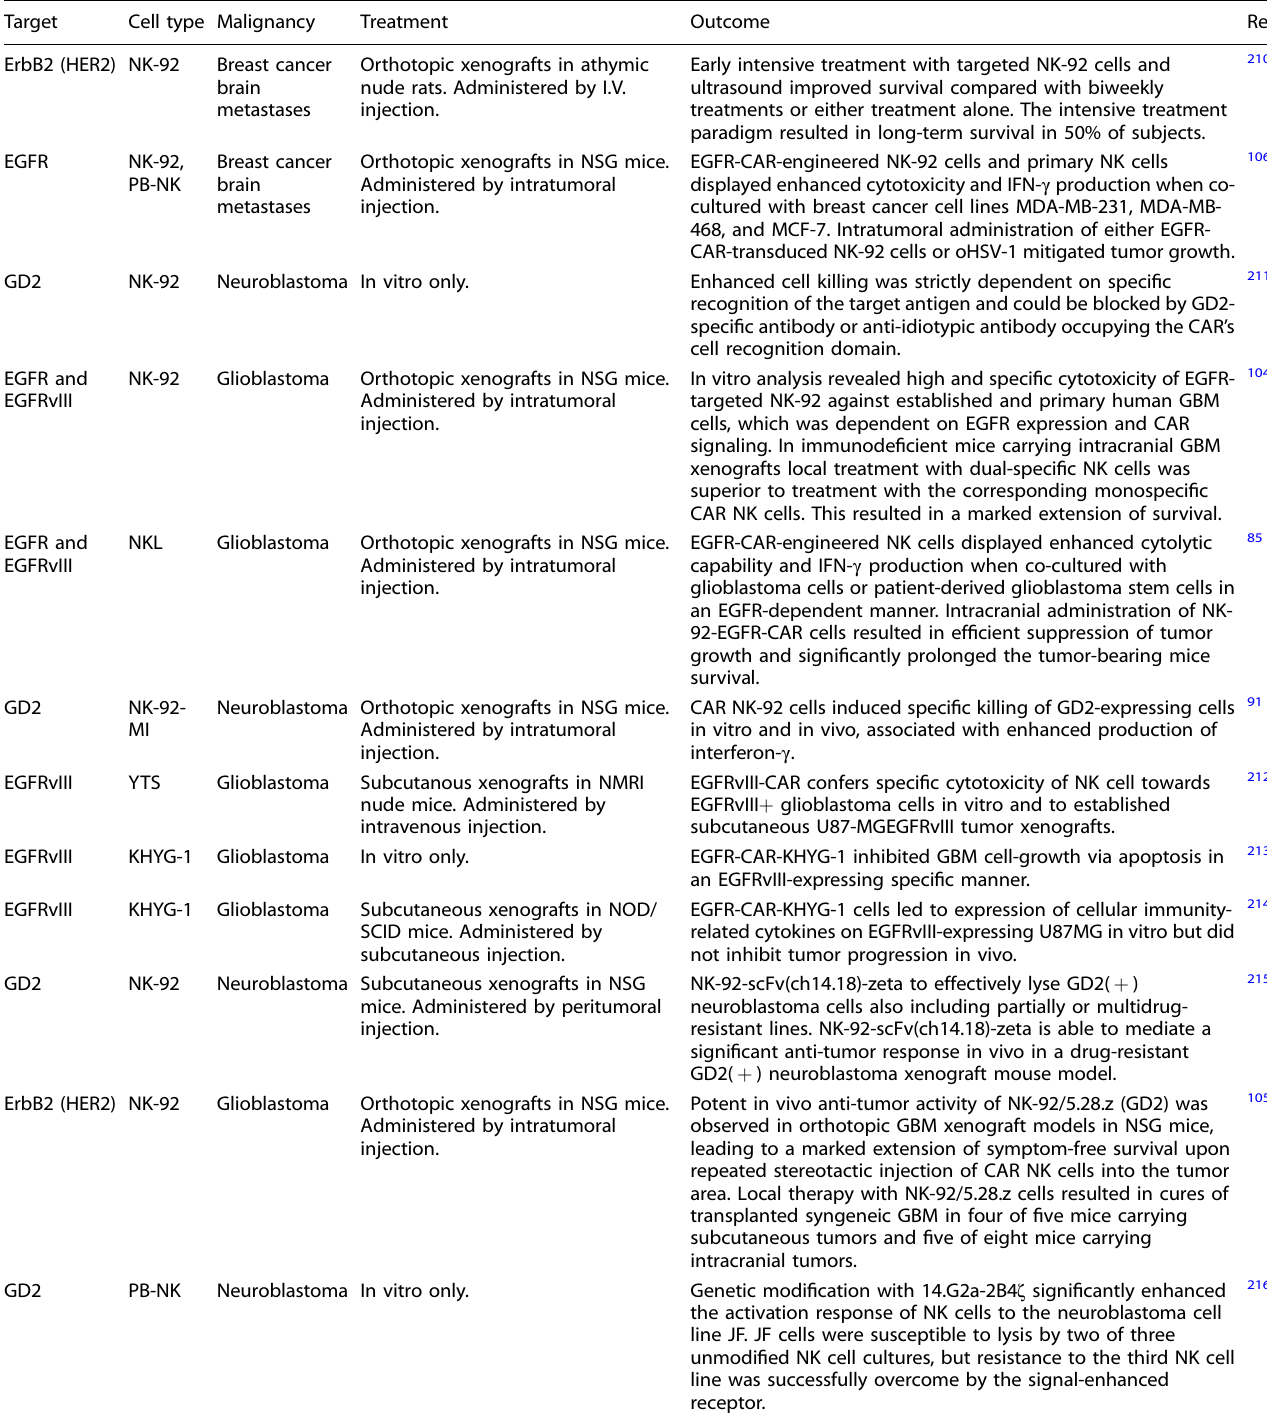
Table 2. Preclinical approaches with CAR-NK cell therapeutics for brain